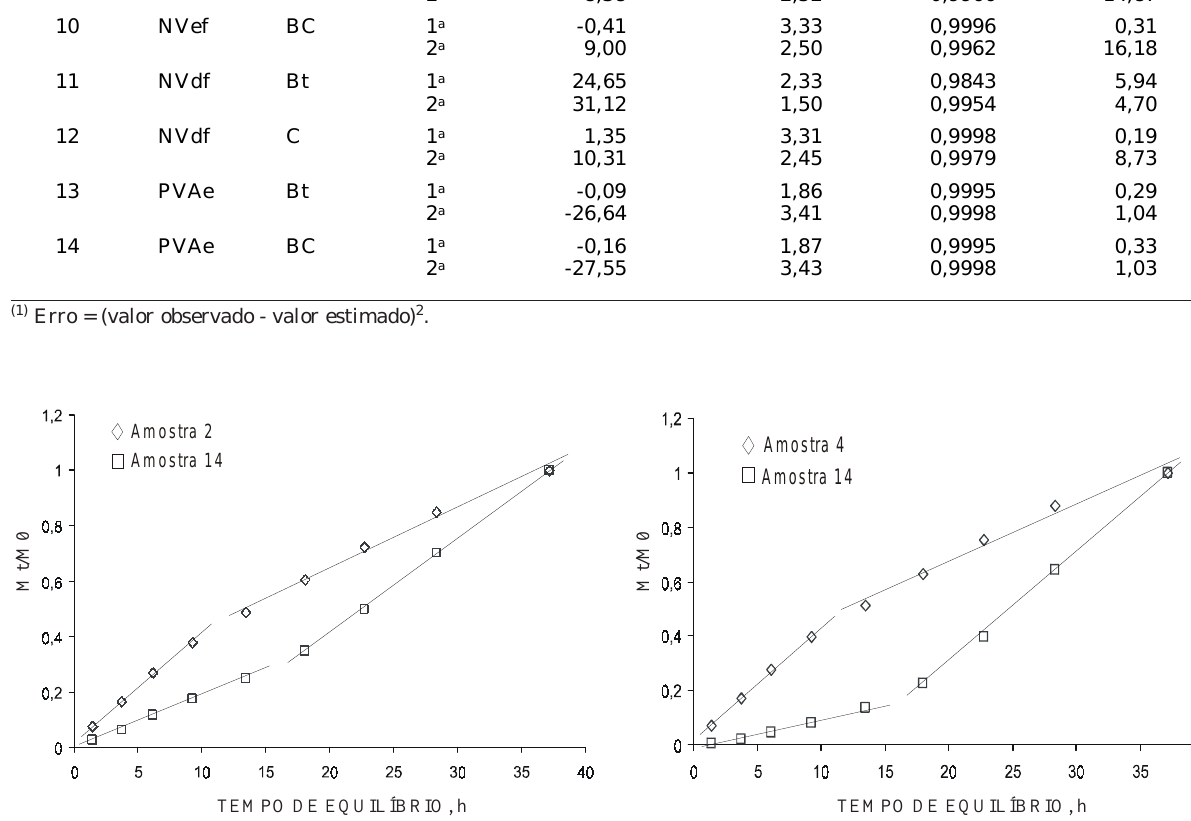
Figura 2. Cinética de liberação de Mg da fração argila do horizonte Bw do Latossolo Vermelho- Amarelo distrófico típico (amostra 4) e do horizonte BC do Argissolo Vermelho-Amarelo eutrófico abrúptico (amostra 14).